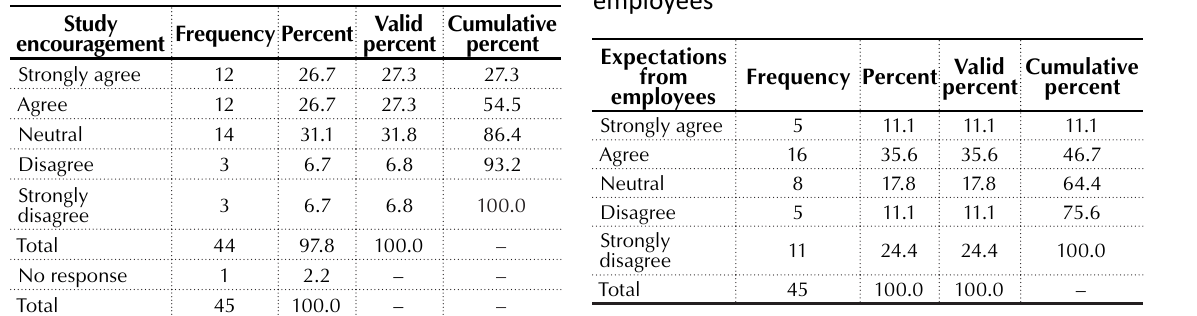
Table 7. Responses on expectations from